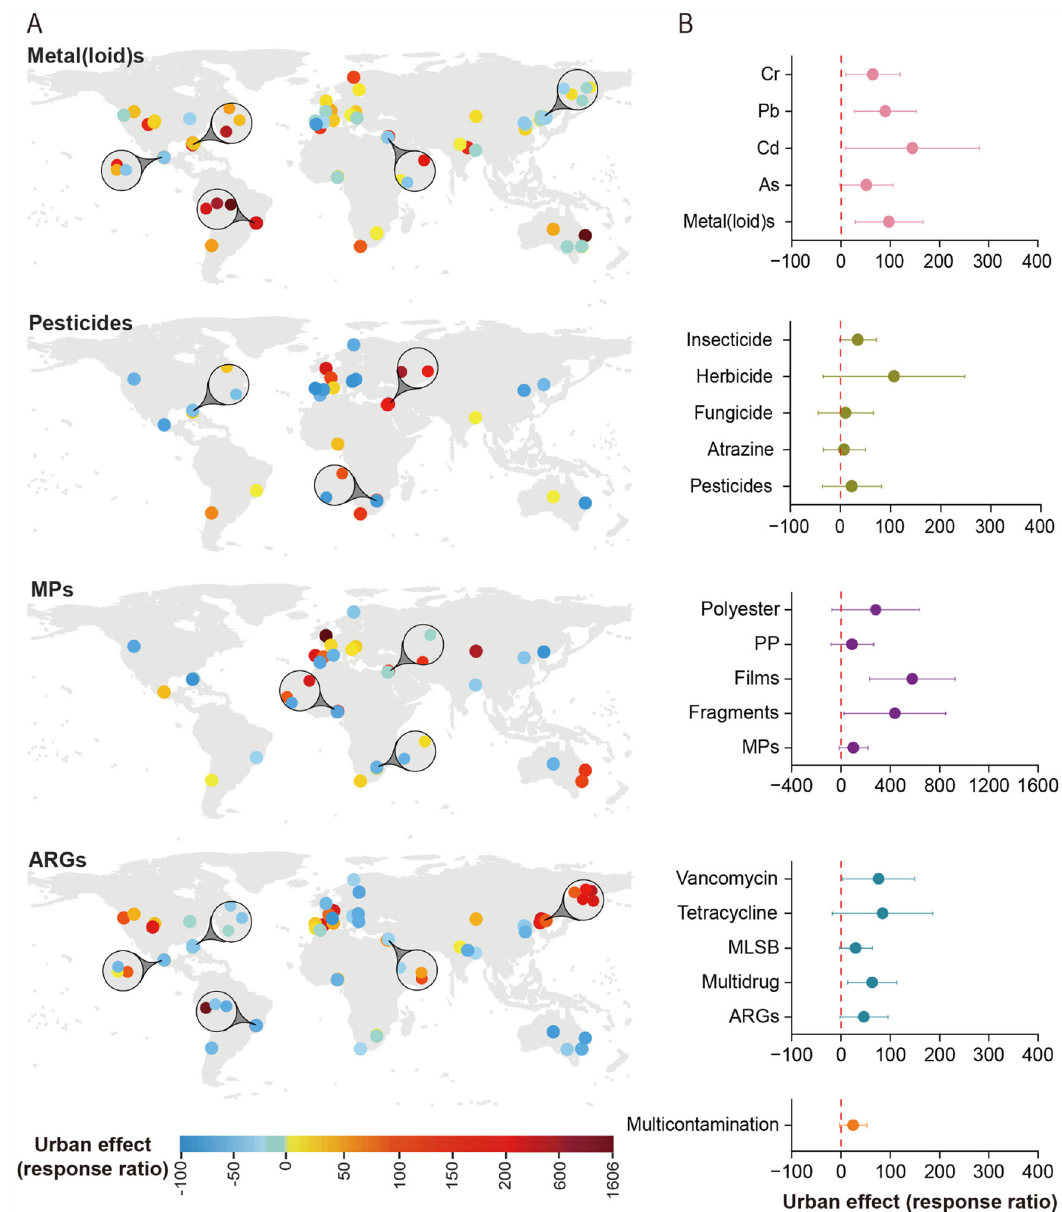
Fig. 1 | Changes (%) in soil contaminants in urban greenspaces compared with adjacent natural areas worldwide. A response ratios of (site-level described in Methods) of standardized contaminant indices of metal(loid)s, pesticides, micro- plastics (MPs), and antibiotic resistance genes (ARGs). B the changes (site-level response ratios, mean ± 95% con fi denceinterval) in the selected soil